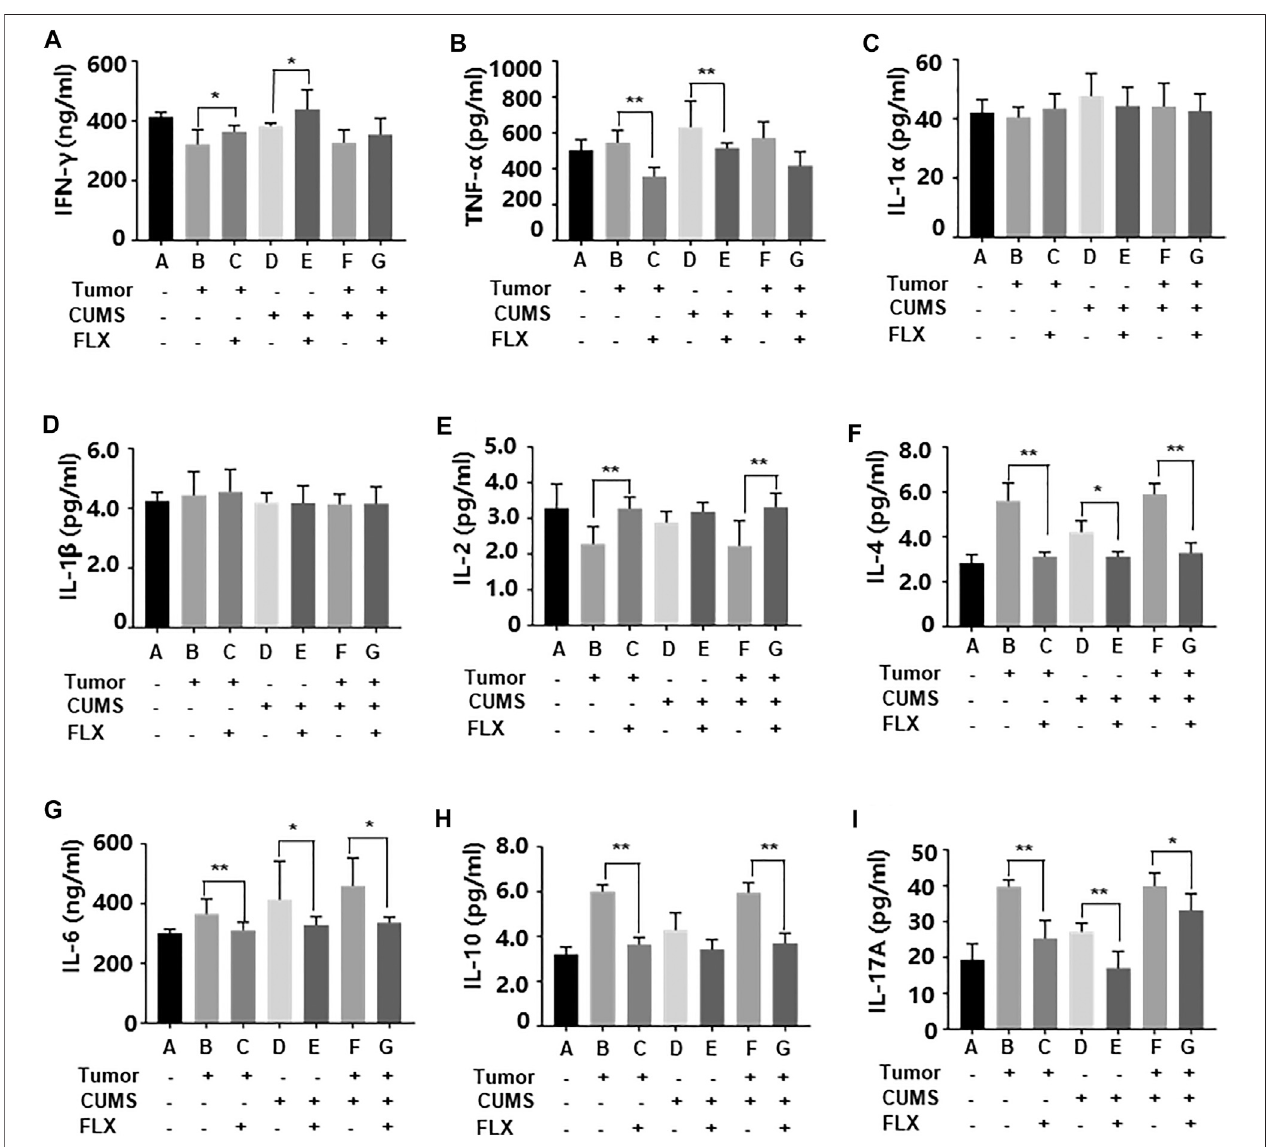
FIGURE6| Levelsofin fl ammatorycytokinesIFN- γ (A) ,TNF- α (B) ,IL-1 α (C) ,IL-1 β (D) ,IL-2 (E) ,IL-4 (F) ,IL-6 (G) ,IL-10 (H) ,IL-17A(i)inperipheralblood. Datawere expressed as mean ± SD. * p < 0.05, ** p < 0.01.